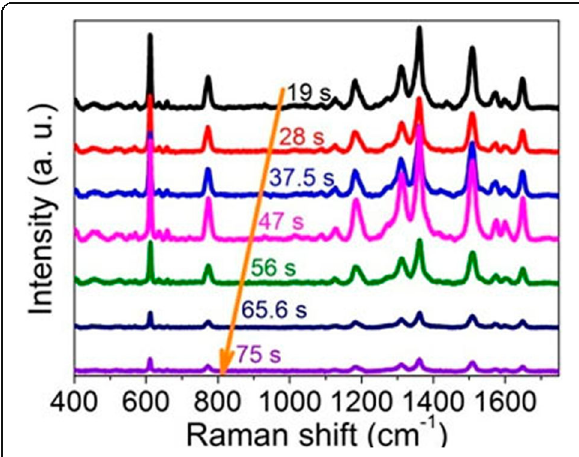
Fig. 2 Raman spectra of the dual-layer porous Au film structures with the sputtering time for each layer of porous Au films increasing from 19 to 75